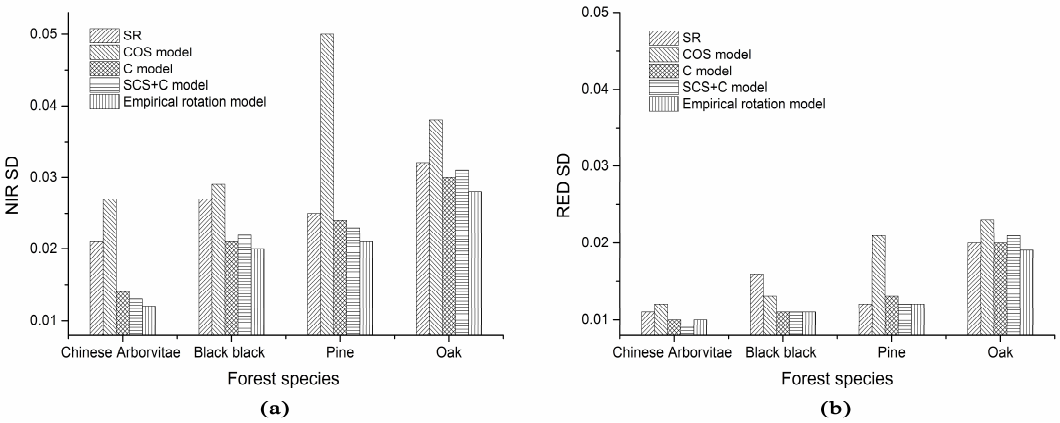
Figure 5. Comparison of tree species NIR band ( a ) and red band ( b ) standard deviation before and after topographic correction by the four models. SR represents the precorrected conditions of the spectral band. The model represents the conditions after topographic corrected by the specific model.